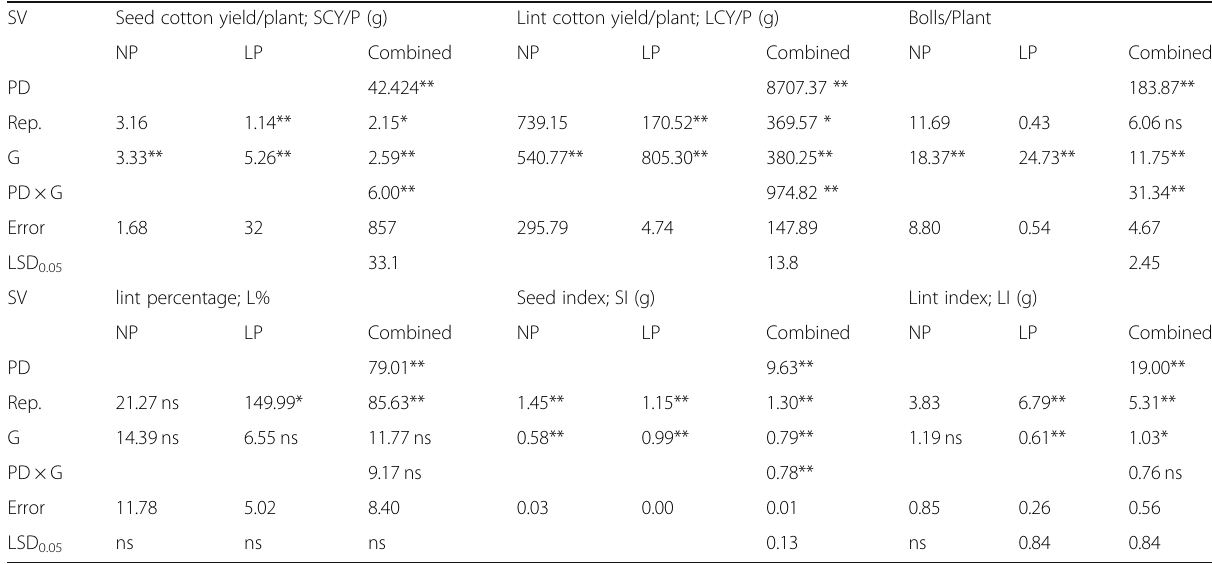
Table 2 Mean squares of four cotton populations genotypes cultivated in normal (NP) and late planting date (LP) SV Seed cotton yield/plant; SCY/P (g) Lint cotton yield/plant; LCY/P (g)